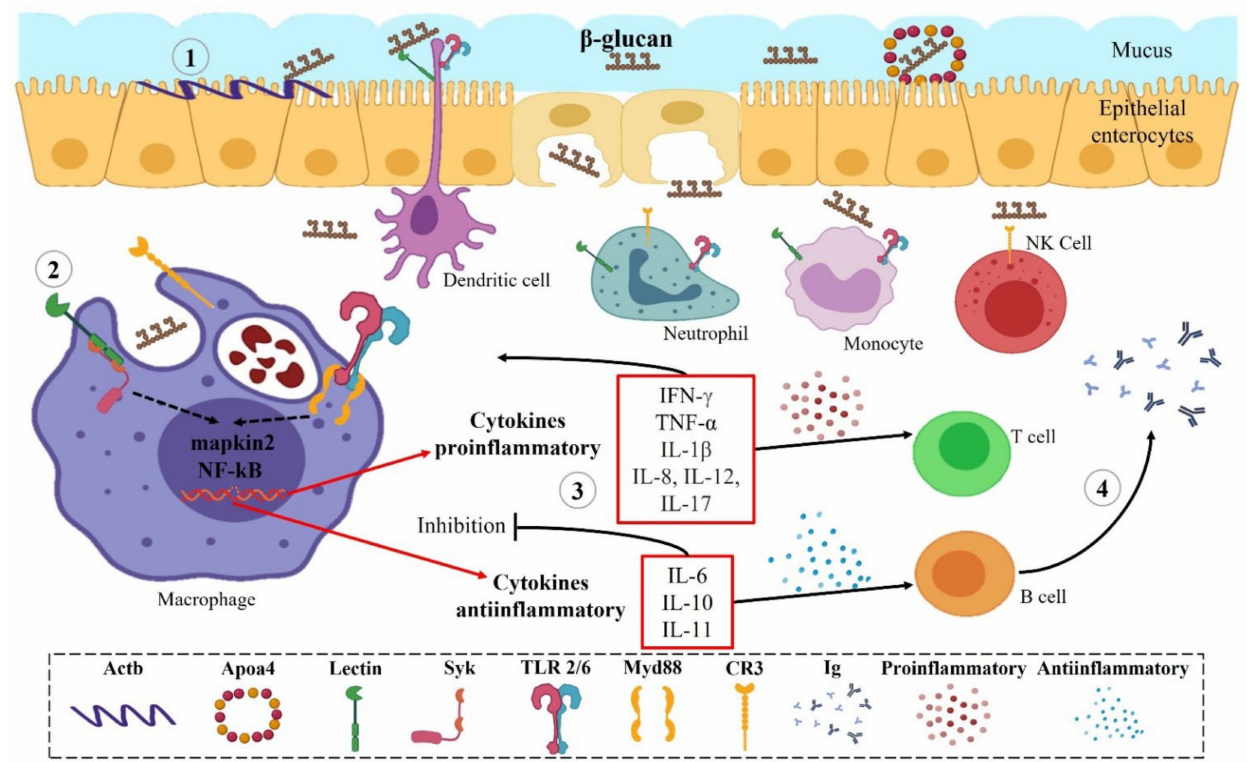
Figure 3. Signaling pathway for yeast β -glucans in teleost fish organisms. Proposed scheme of the β -glucan activation pathway in fish. (1) Intestinal epithelial enterocytes synthesize metabolic proteins activated by yeast β -glucan that secretes them into the systemic circulation. (2) Recognition of β -glucan by pathogen-associated molecular pattern receptors (PAMPs) that generate innate cellular immune responses and gene expression through translocation of the nuclear factor kappa beta (NF- κ B) by phosphorylation, ubiquitination, and protein degradation. (3) Production of pro- and anti-inflammatory cytokines, receptors, and other proteins that activate the communication and activity of the adaptive immune system. (4) Production of immunoglobulins by B cells activated by the recognition of β